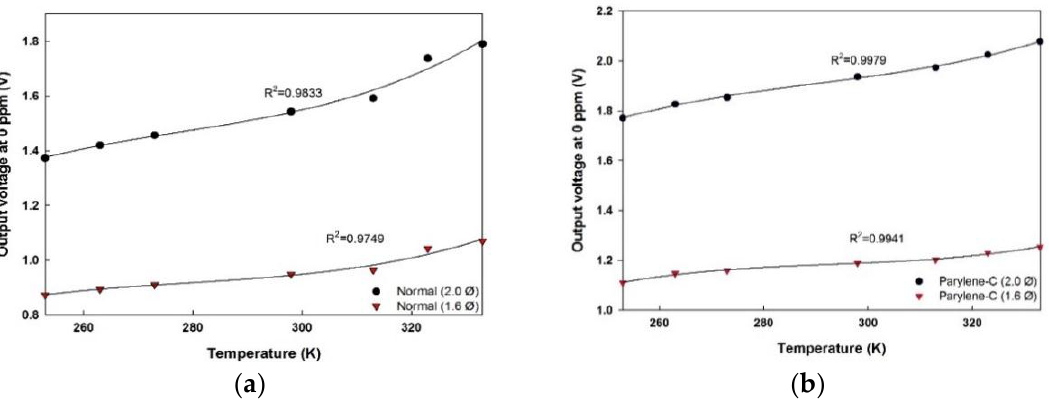
Figure 8. Output voltages at 0 ppm ethanol concentration with varying temperature obtained from ( a ) normal sensor module; ( b ) sensor module with Parylene-C deposition.